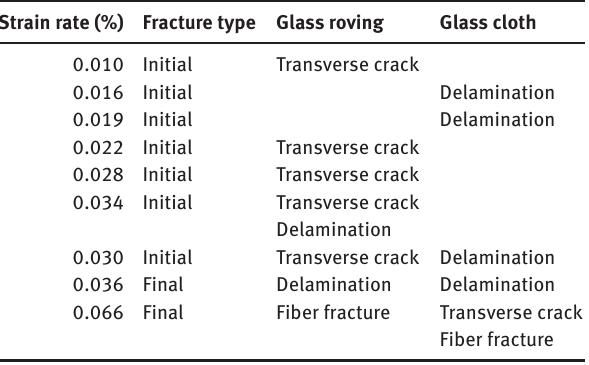
Table 2 Correspondence between the dominant modes of damage and strain